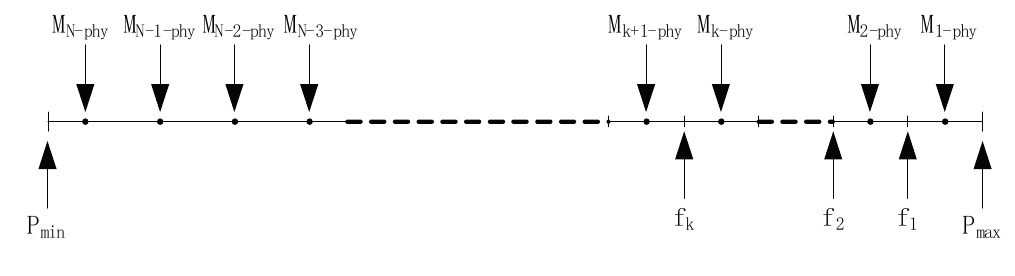
Figure 7. Initial distribution of the readings and